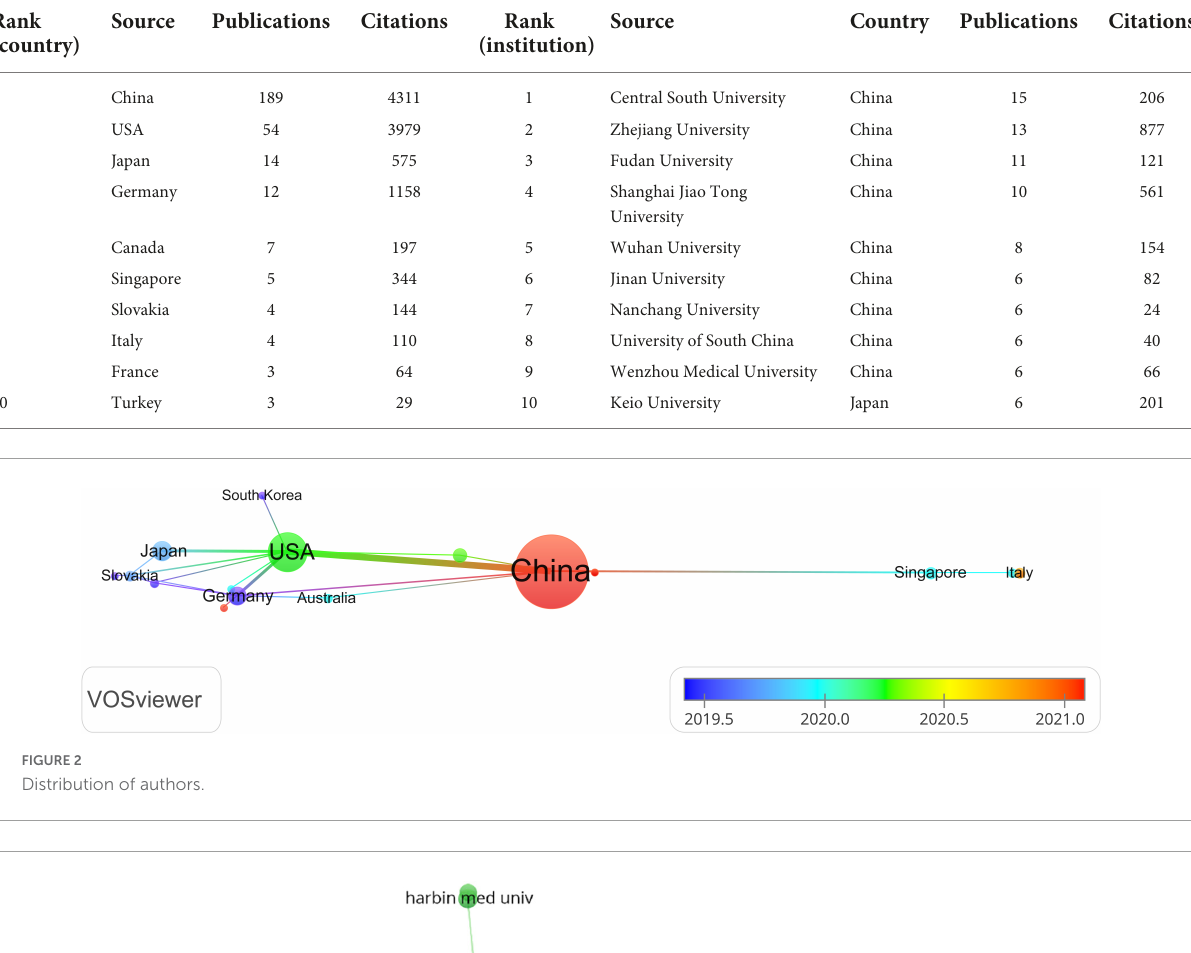
TABLE 2 Specific information of the top 10 countries and institutions.